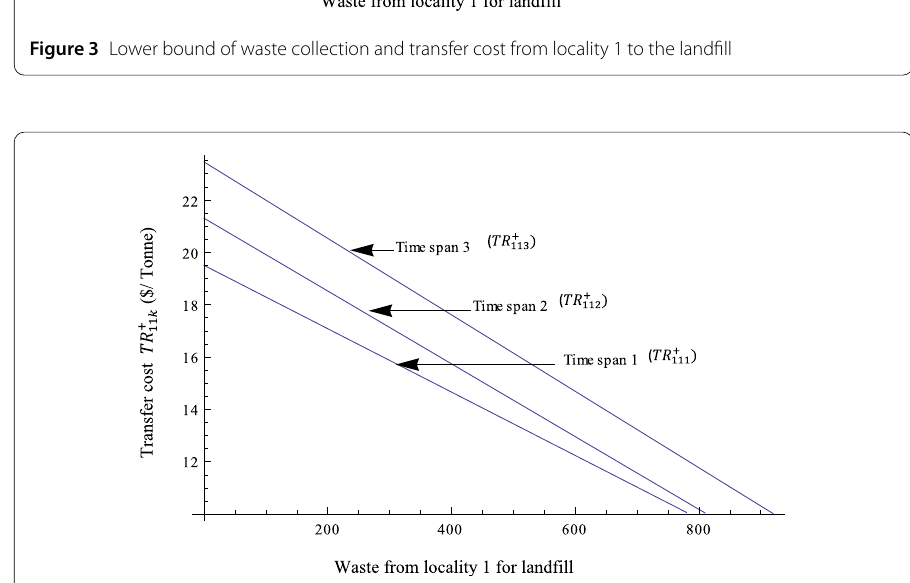
Figure 4 Upper bound of waste collection and transfer cost from locality 1 to the